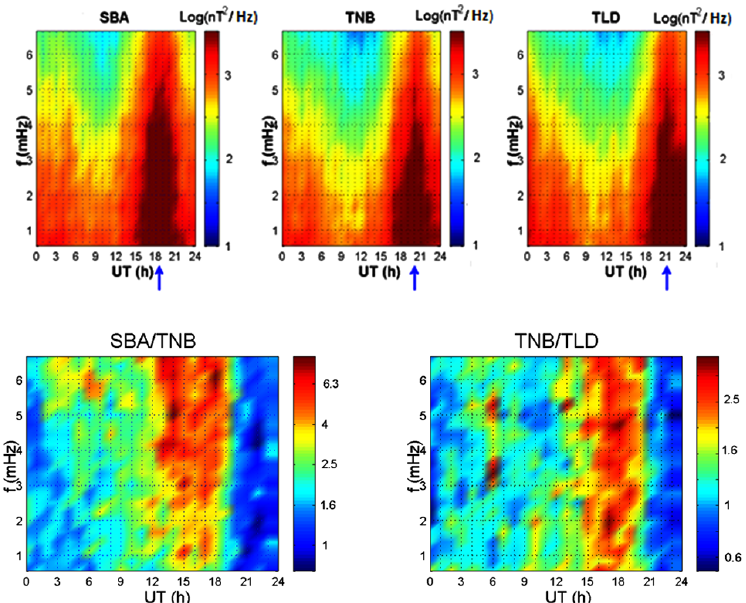
Figure 6. Upper panels: average power spectra of the H component at the three stations. Lower panels: average ratio between power spectra at pairs of stations.